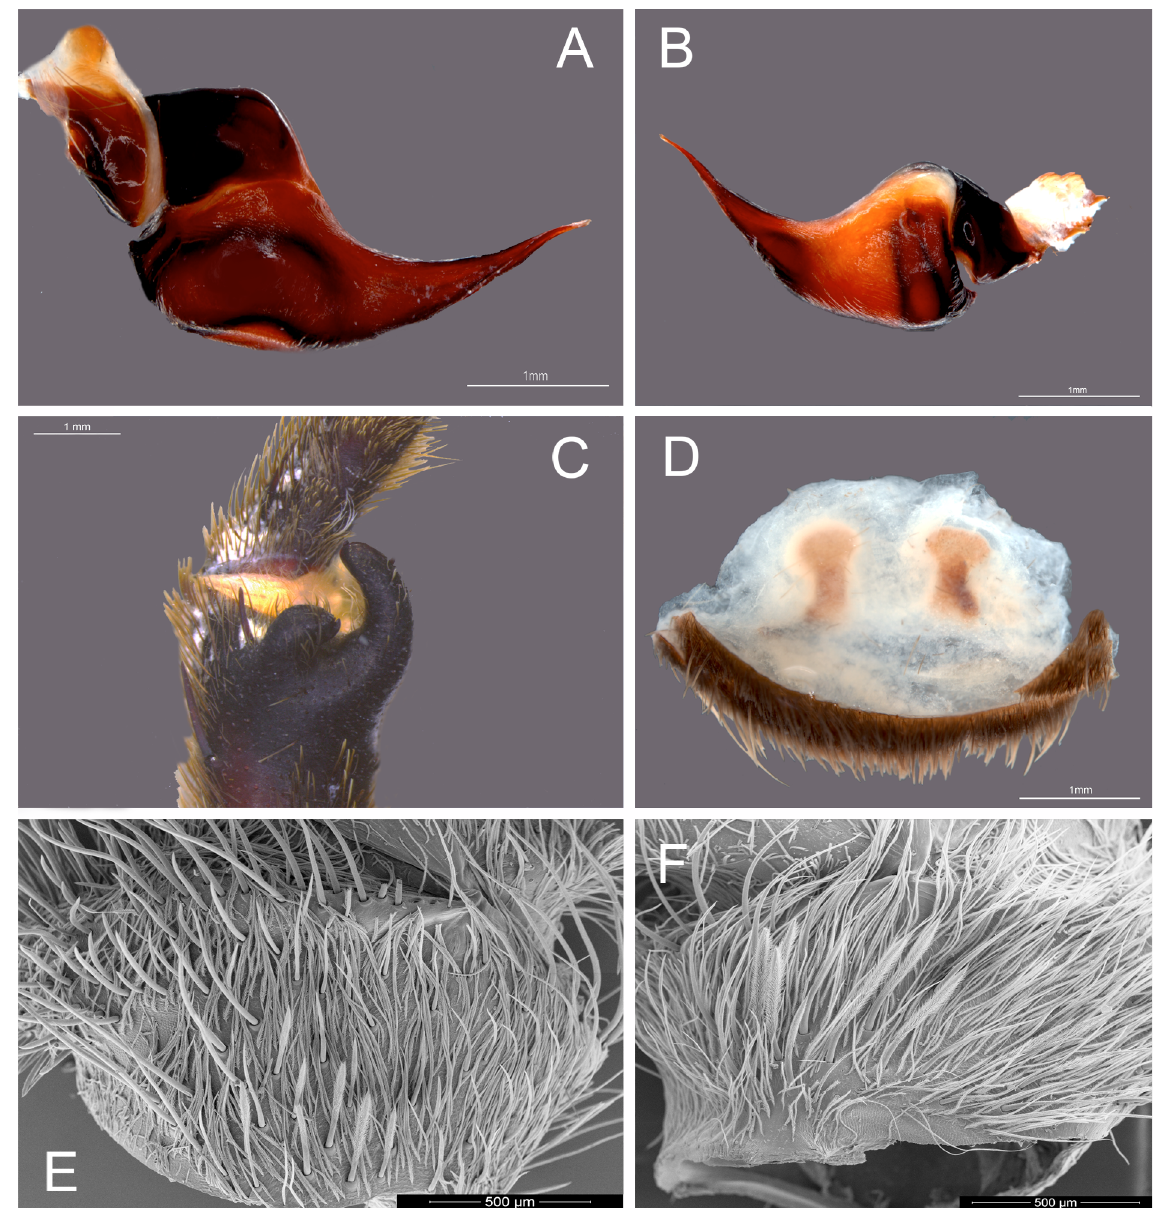
Fig. 2. Cyrtopholis sp., ♂ (MNHNSD 09.1463) and ♀ (MNHSD 1454), Parque Nacional Valle